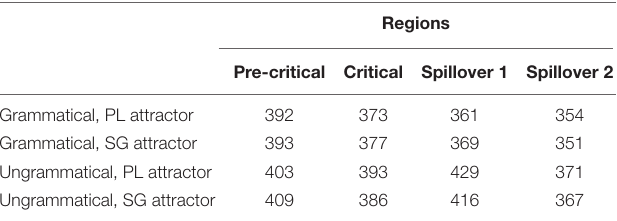
TABLE 8 | Mean reading times (ms) by condition at the regions of interest for Experiment 3.